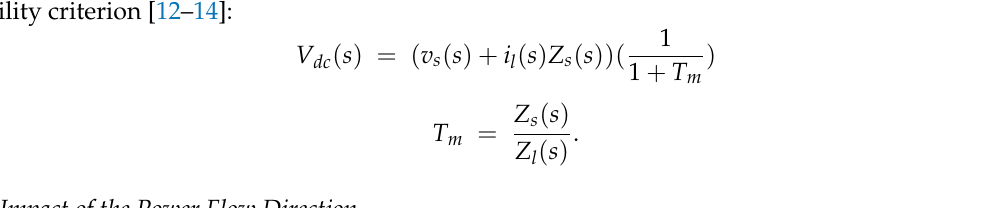
Figure 7. Equivalent model of the VSC–HVDC system.